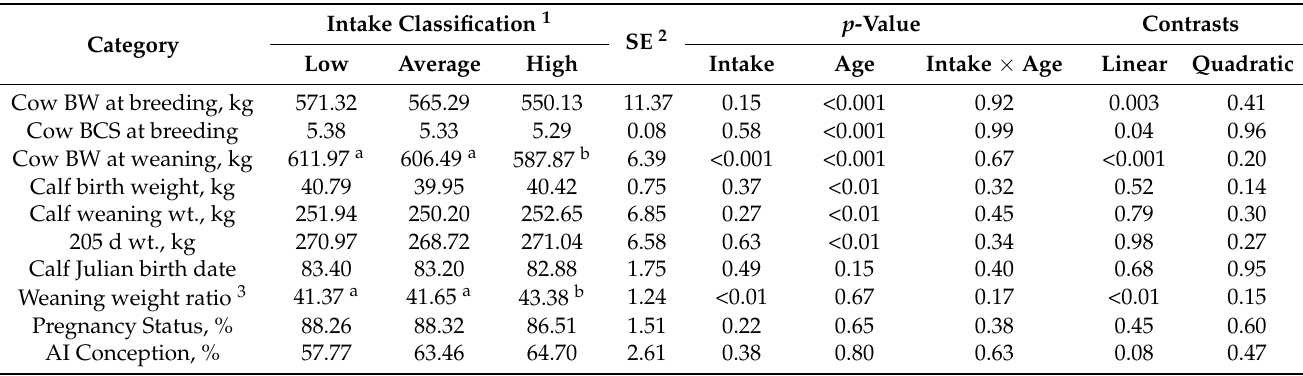
Table 1. The influence of heifer post-weaning intake classification expressed as g per kg body weight on subsequent production and reproductive characteristics in Angus beef females.